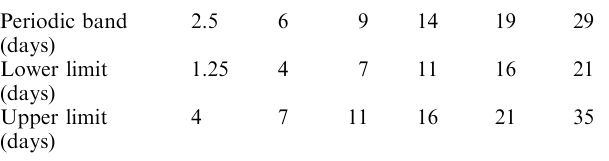
F2 in the periodic range from o F2 quasi-periodic bands in o